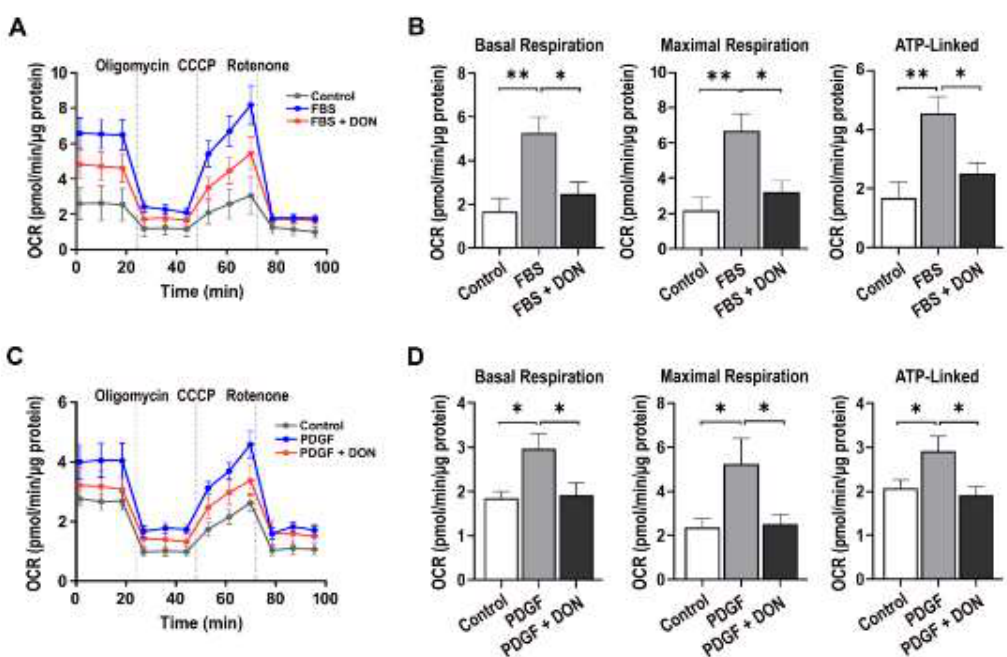
Figure 1. DON reduces mitochondrial respiration in growth factor-stimulated VSMCs. ( A ) and ( C ) OCR kinetic traces in FBS ( A )- and PDGF ( C )-stimulated VSMCs treated with or without DON. ( B ) and ( D ) Rates of basal, maximal, and ATP-linked respiration in FBS ( B )- and PDGF( D )-stimulated VSMCs treated with or without DON. Data are expressed as the mean ± SEM ( n = 3 technical replicates). * p < 0.05 and ** p < 0.01.